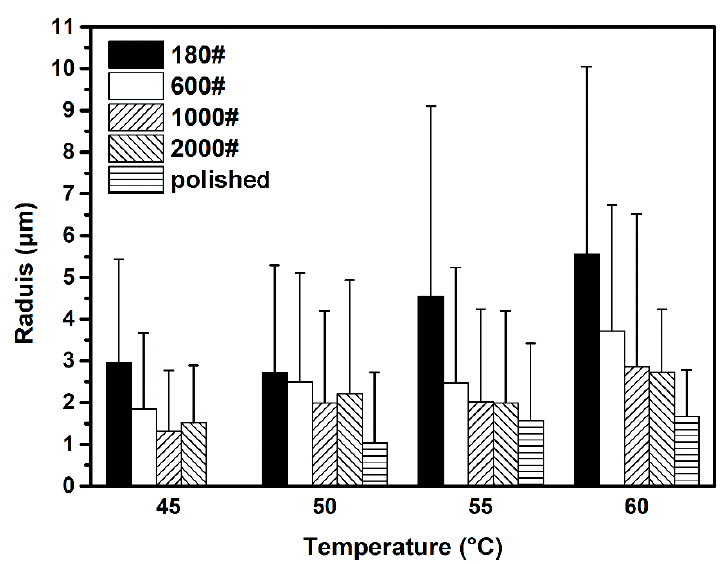
Figure 16. Average radius of metastable pit on different surface roughness DSS 2205 specimens at four solution temperatures.